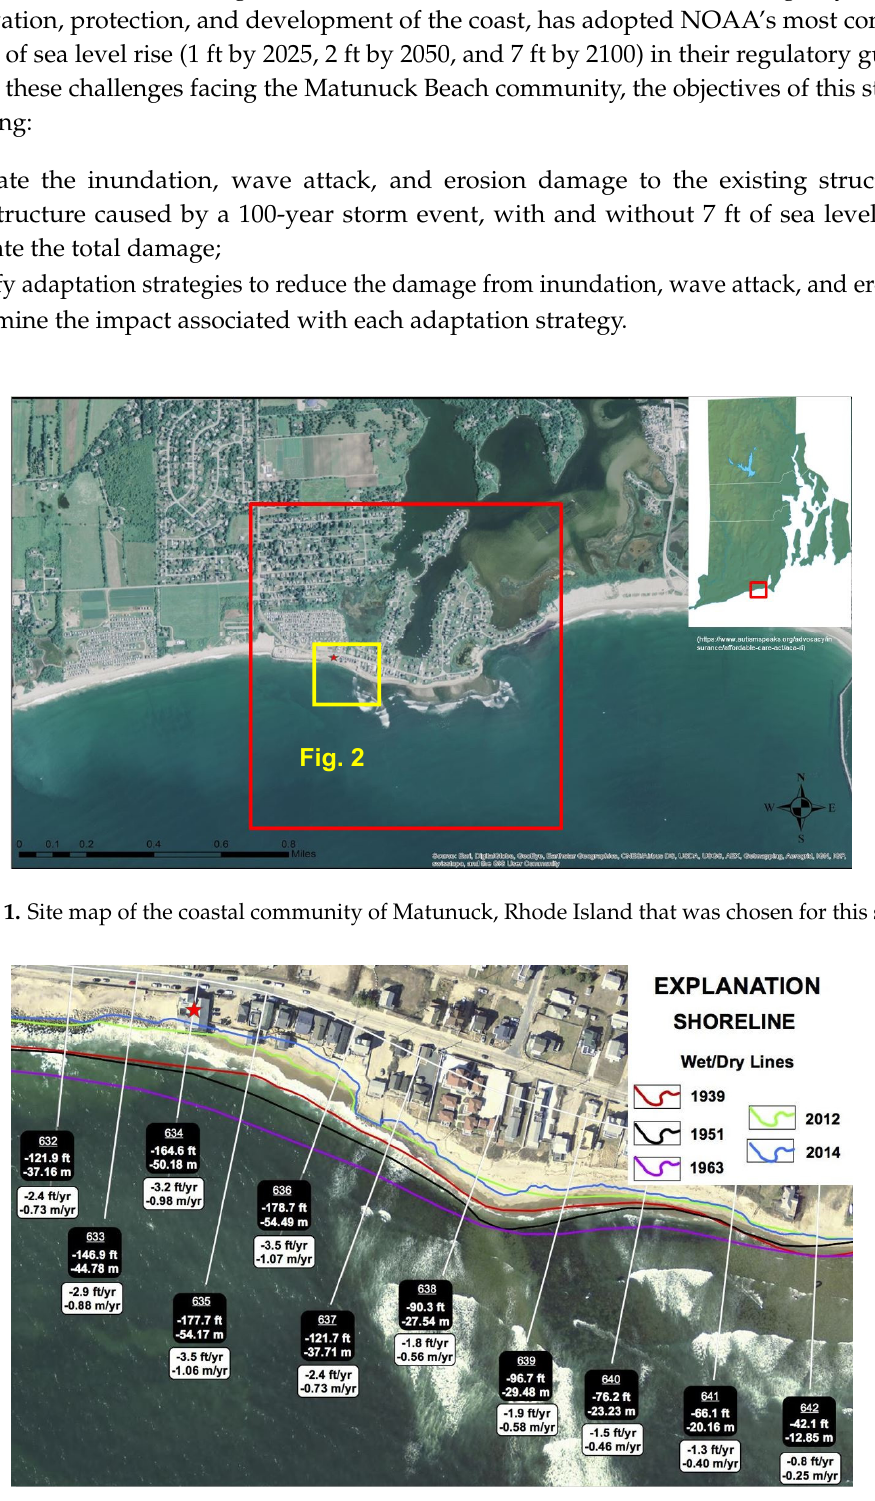
Figure 2. Shoreline change rates for the study area [1].